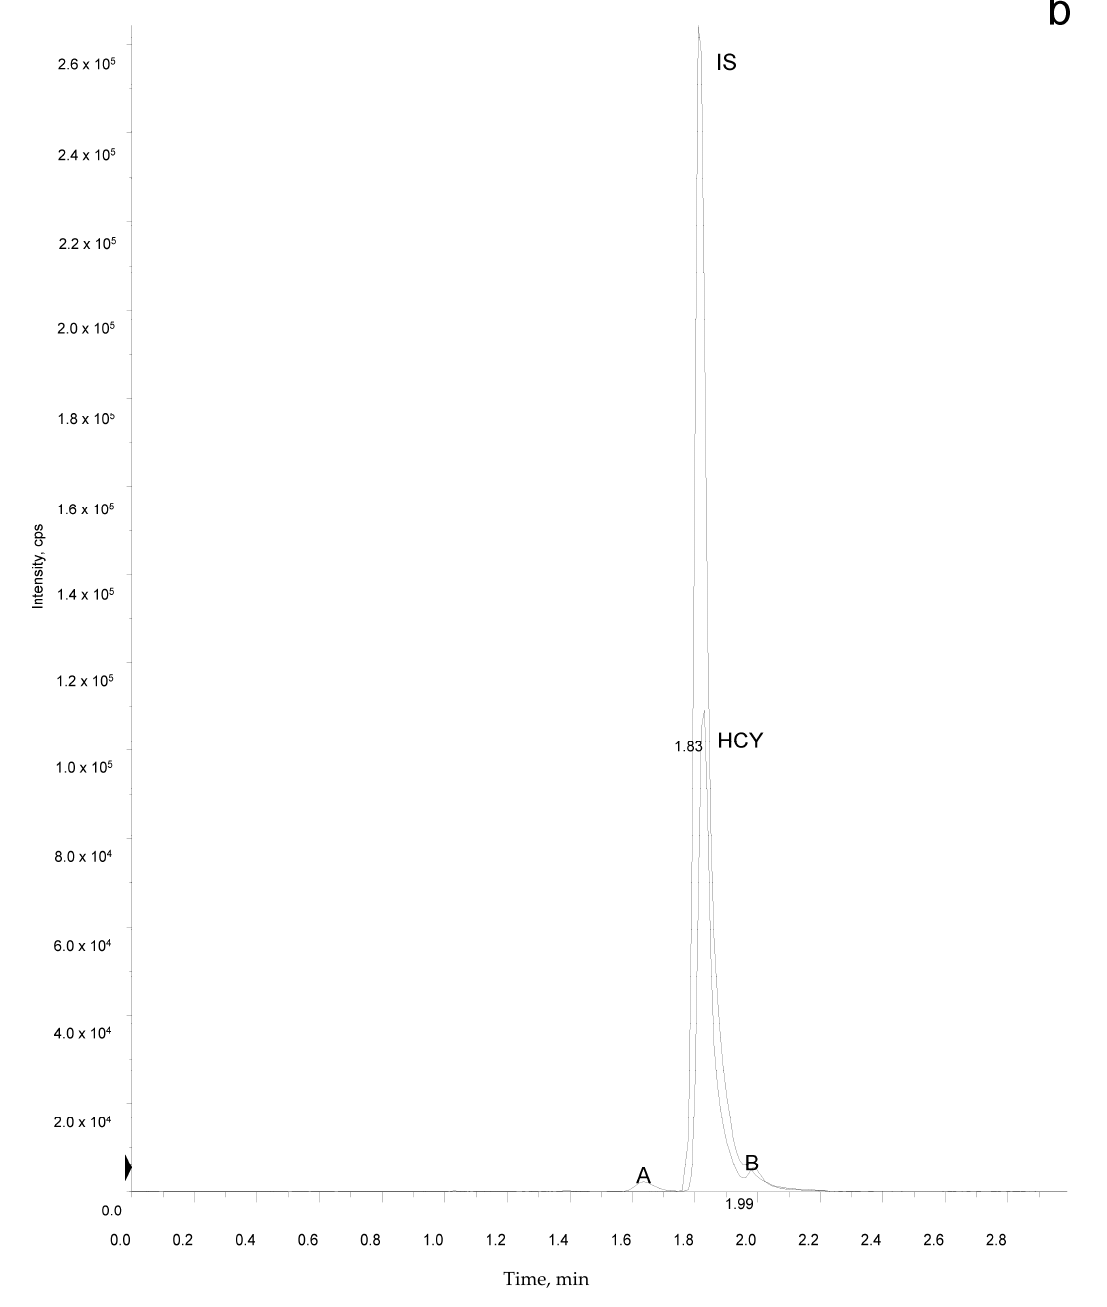
Figure 1. ( a ) A chromatogram of a normal sample with a total homocysteine (tHCY) level of concentration of 4.4 µmol/L; ( b ) A chromatogram of a sample from a patient with a confirmed diagnosis of HCU with a tHCY concentration of 56 µmol/L. In both ( a ) and ( b ) peaks A and B